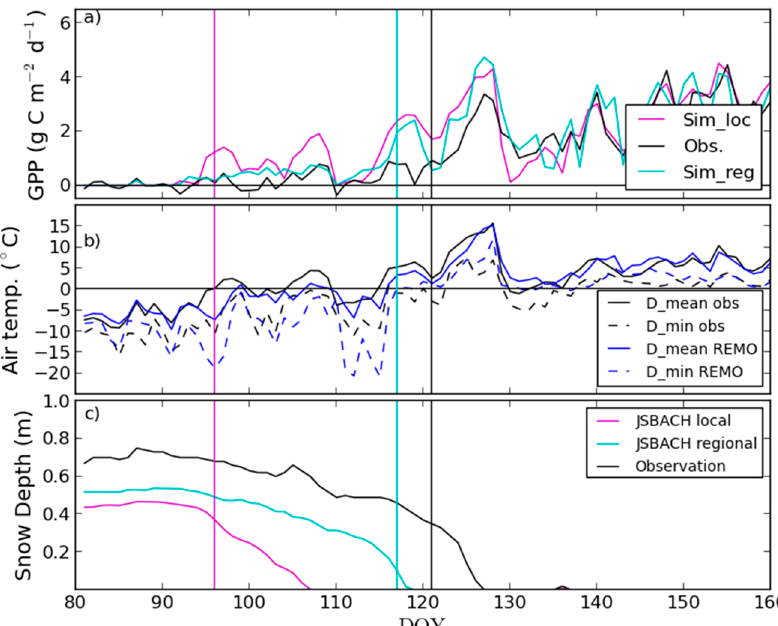
Figure 4. ( a – c ) Daily GPP (Gross Primary Production), mean and minimum air temperature and snow depth for Sodankylä in spring 2004. Vertical lines indicate the start of season (ENF_SOS): JSBACH local (magenta) refers to ENF_SOS mod,loc ; JSBACH regional (cyan) is ENF_SOS mod , and observation refers to ENF_SOS EC (black).